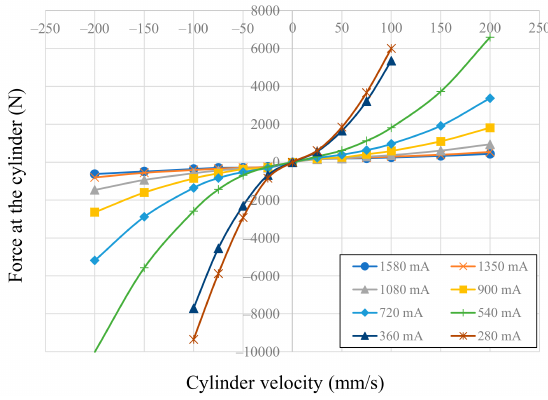
Figure 17. Force-velocity curve according to applied valve current change.